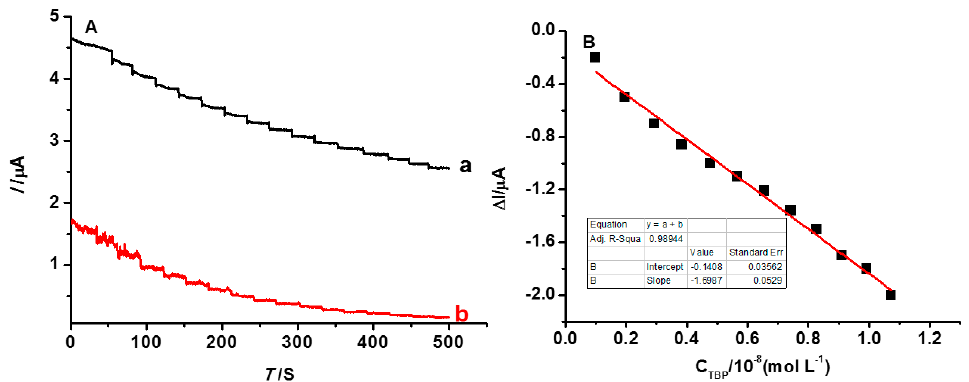
Figure 9. ( A ) is AC of the sensors (a: INS, b: NINS); and ( B ) shows the linear relation of ∆ I ~C TBC .